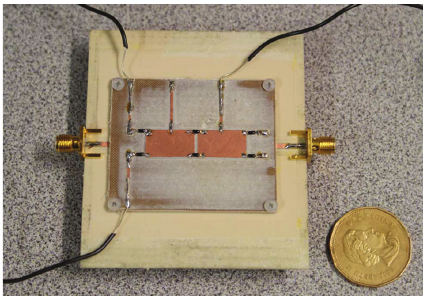
Figure 7: Frequency tunable differentially fed patch antenna